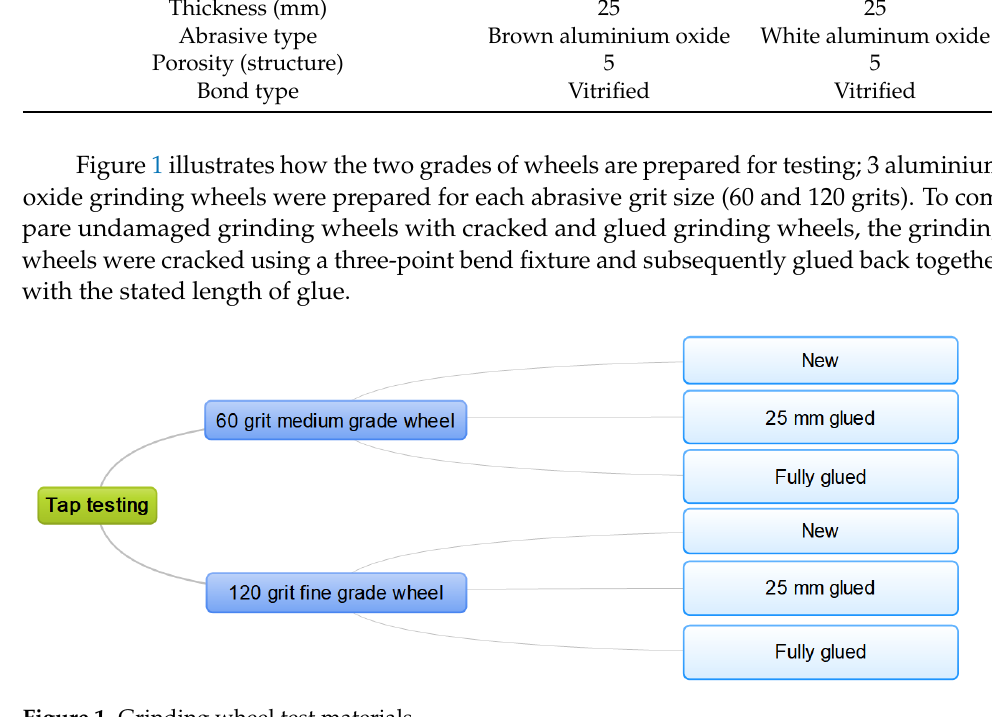
Figure 1. Grinding wheel test